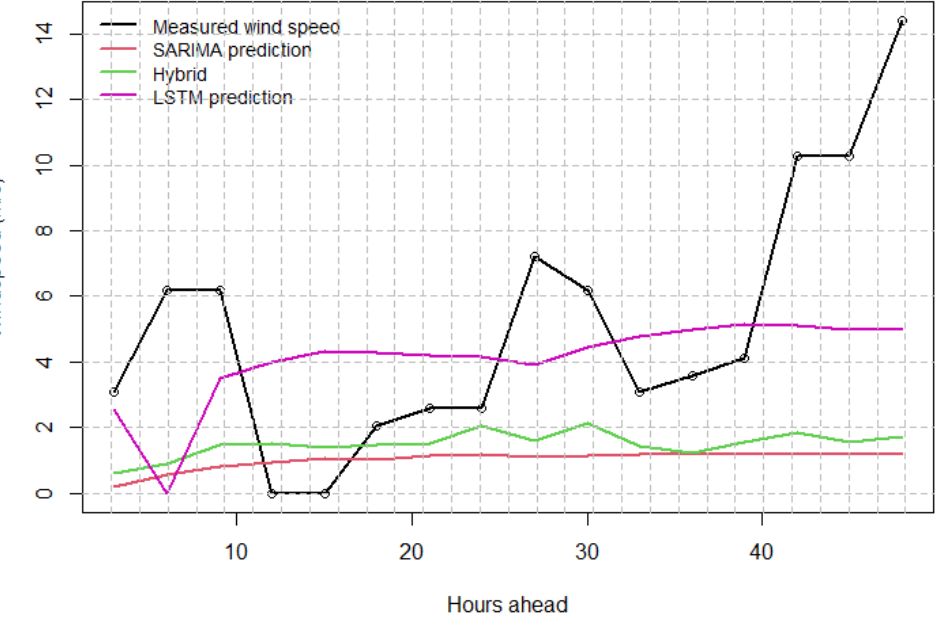
Figure 12. Comparison of SARIMA, LSTM and hybrid with real data for 2-day prediction horizon during December; wind speed example; low wind speed during previous days.